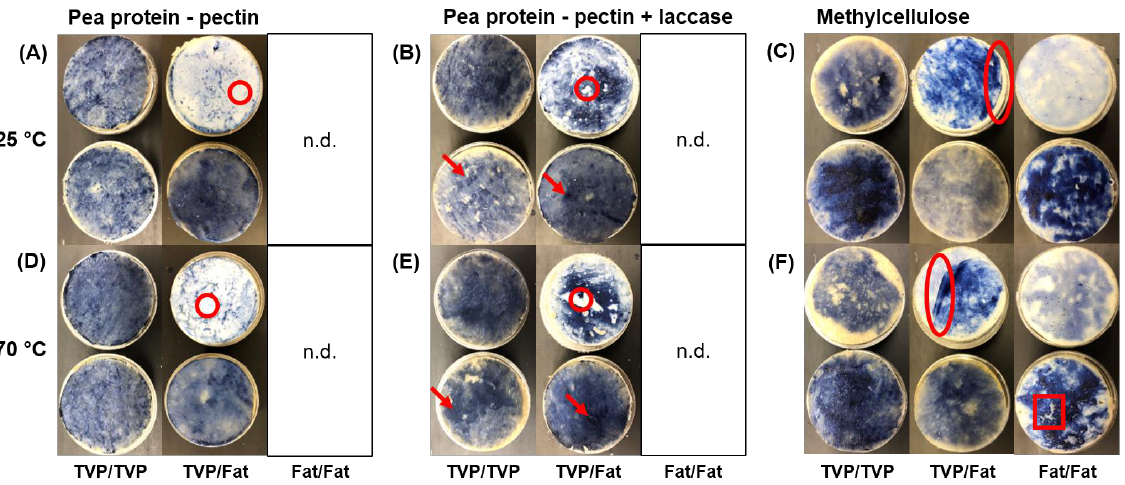
Figure 3. Images of pea protein – sugar beet pectin mixtures (r = 2:1, 25% w / w , 100 mM NaCl) without laccase ( A , D ) and with laccase ( B , E ), and methylcellulose hydrogels ( C , F ) acting as binder between textured vegetable protein(s) (TVP) and/or fat mimetic (s) (Fat) at 25 °C and 70 °C after tensile strength test. Red arrows indicate clusters of binder; red circles show failure of binder adhesion; red oval shapes indicate cohesive methylcellulose layer; and red squares show ruptured fat mimetic. Note that binder was dyed with brilliant black for better visualization. n.d. = not determined due to failure to apply the binder on the fat mimetic directly.